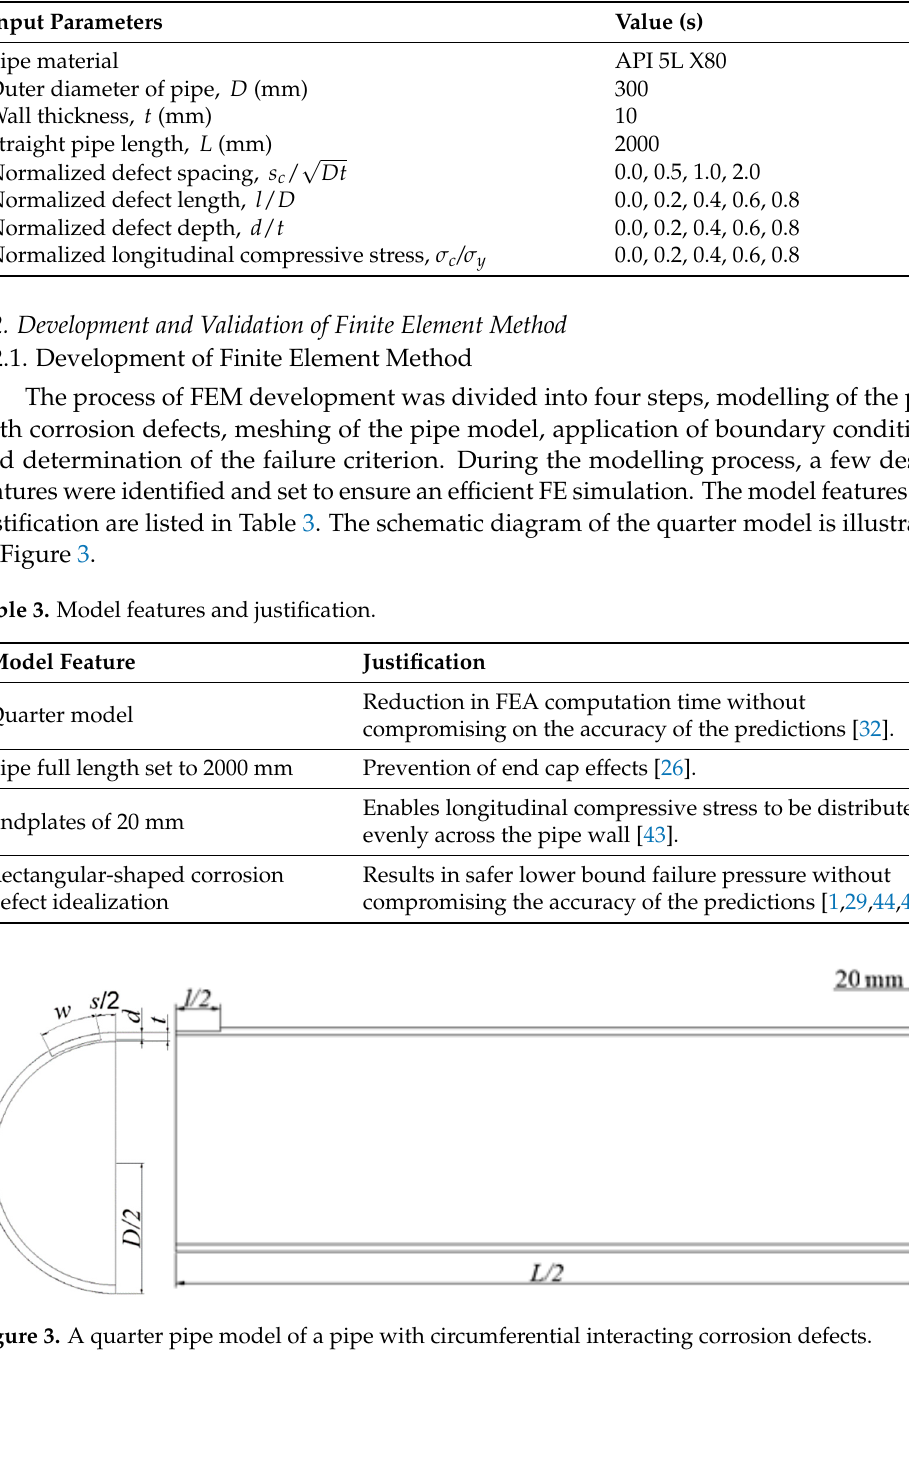
Table 2. Geometric parameters for finite element analysis (FEA) parametric study.